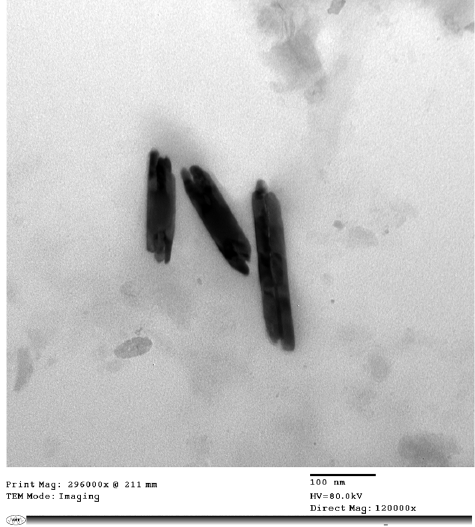
Figure 3. Transmission electron micrograph showing the rod-shaped biogenic TeNPs produced by Gayadomonas sp. TNPM15.